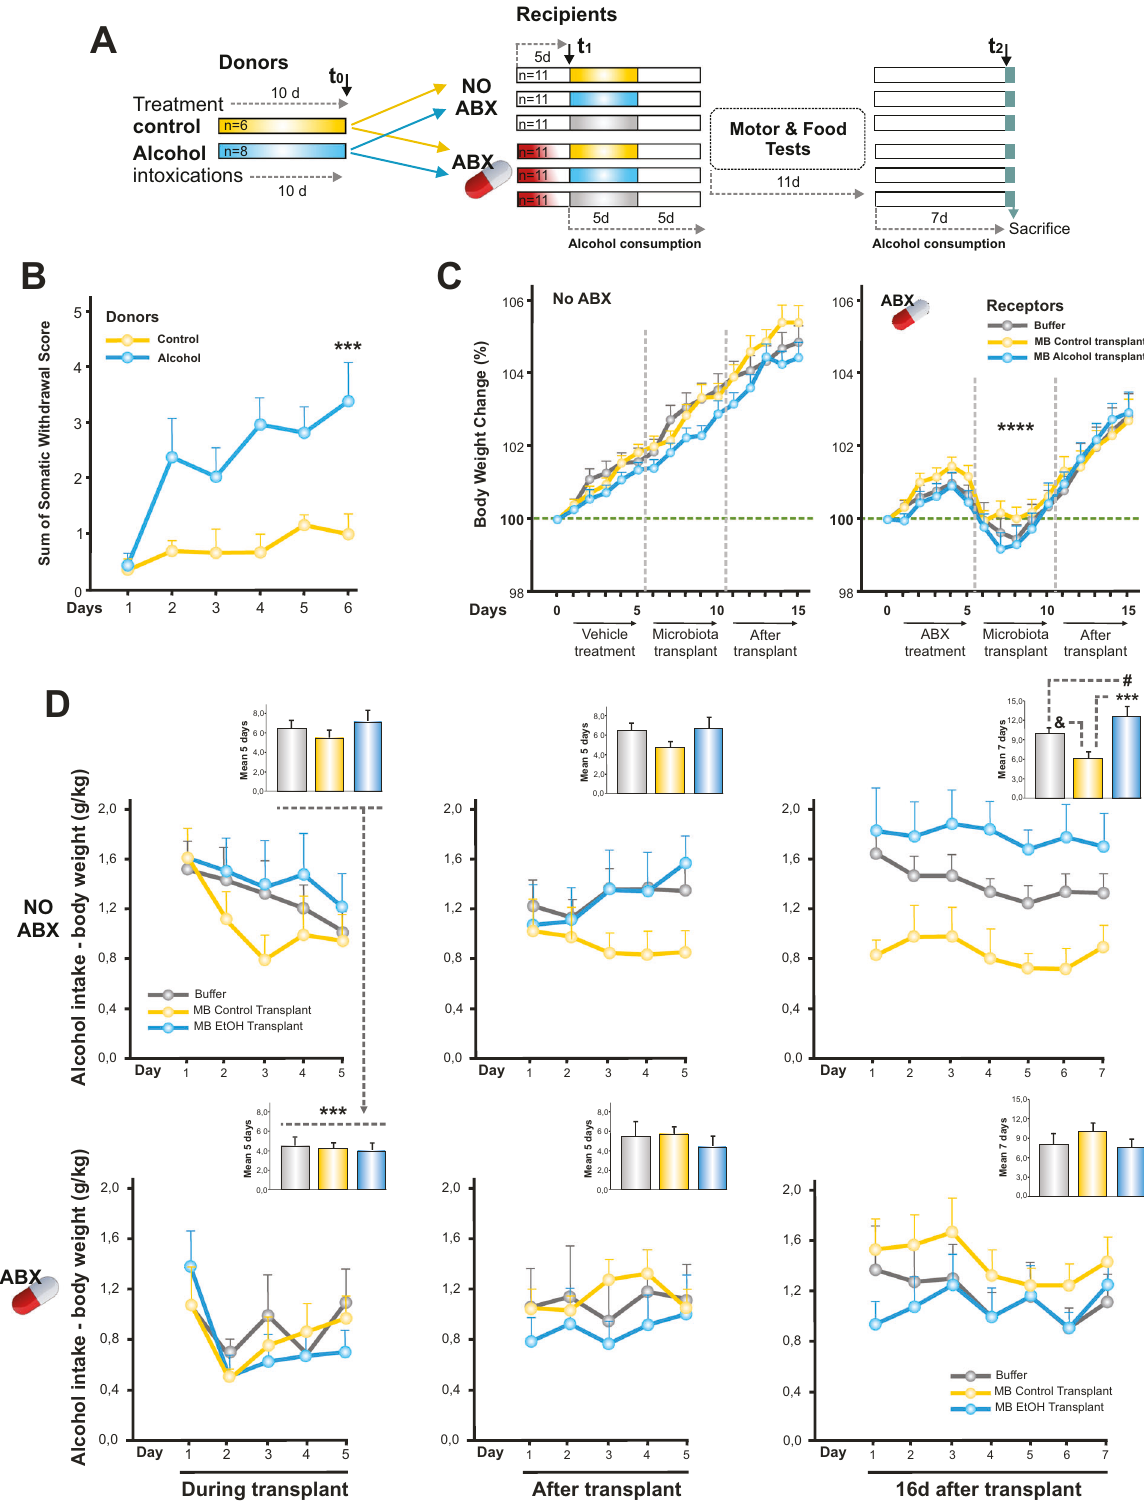
and Evenness ( p < 0.09) indices (Fig. 1C). That means that bacteria were evenly distributed within each group. However, Beta diversity, which it considers the between-group differences in diversity, showed signi fi cant differences ( p < 0.005, based on the Jaccard distance index) (Fig. 1D). Regarding the relative